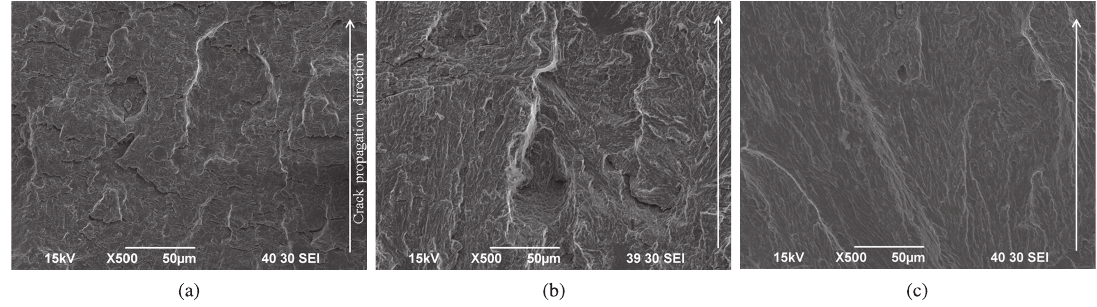
Figure 7. Fractography of fatigue fractured specimens for the HAZ at crack growth (Zone II): (a) the lowest amount of river patterns on the as-received condition, (b) normalized for 5 hours with increase in the amount of river patterns, and (c) normalized for 10 hours with the highest amount of defined river